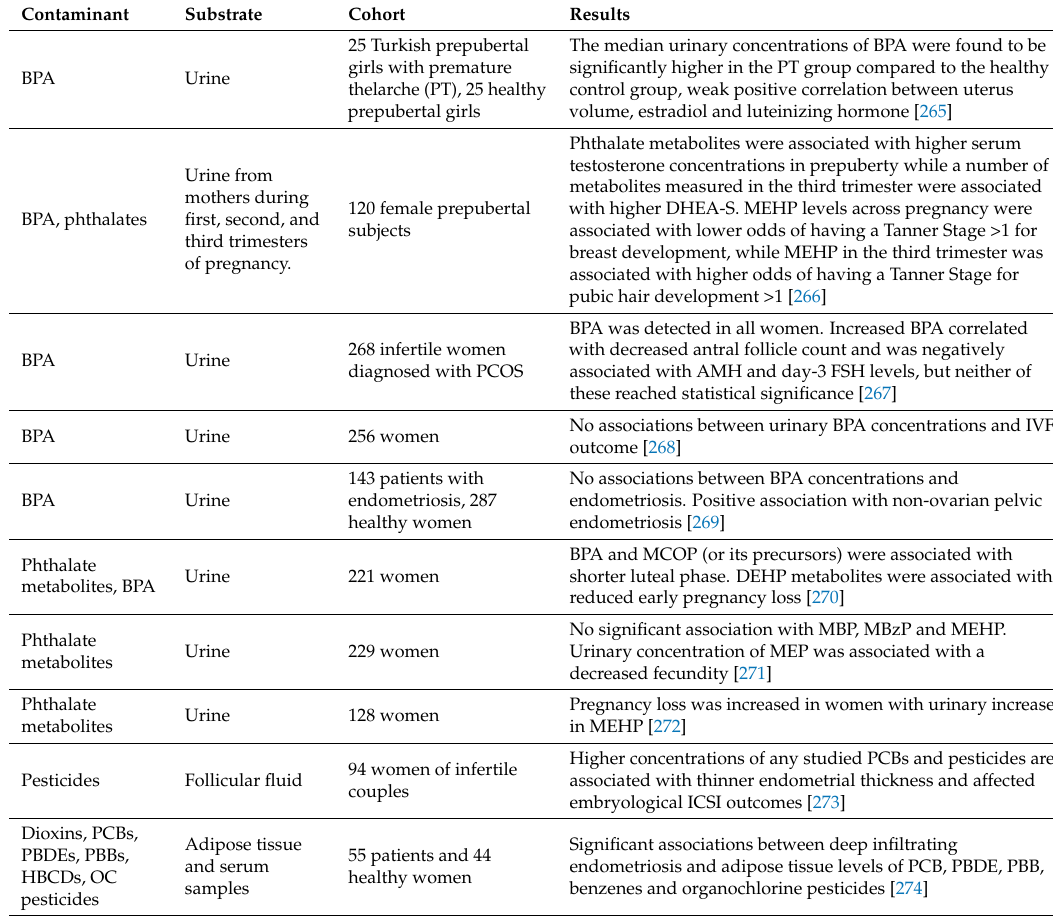
Table 3. Recent evidences on the effects of EDCs on fertility in women.